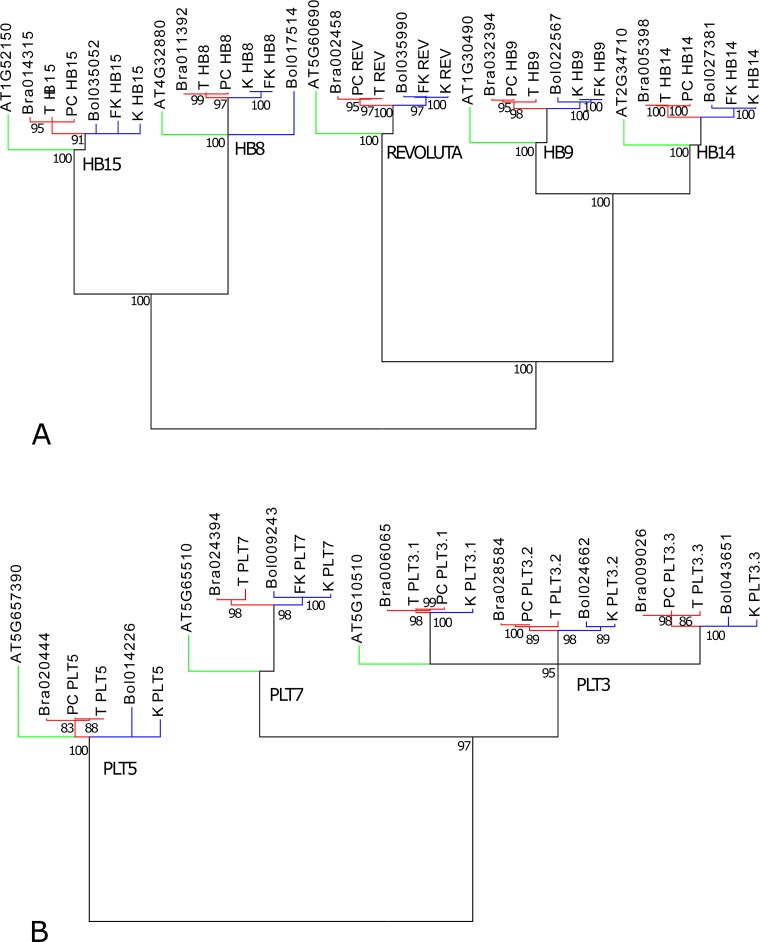
Gene family analyses of transcripts that were assembled by reference to the Brassica rapa genome.(A) HB gene family. (B) PLT gene family. Green: Arabidopsis thaliana; red: Brassica rapa; blue: B. oleracea. Assembled transcripts PC: pak choi; K: kohlrabi; FK: flowering kale. Numbers below nodes are maximum likelihood bootstrap percentages. Nodes with less than 90% (A) or 83% (B) bootstrap support were collapsed.